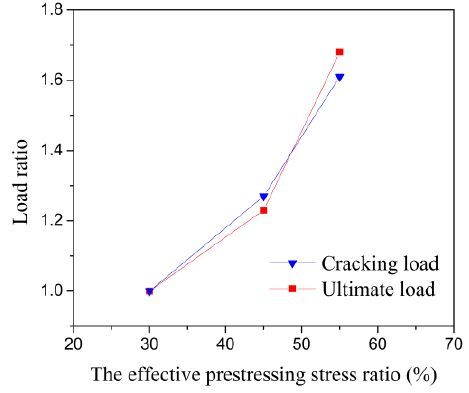
Figure 15. The influence of f pe on flexural capacity.